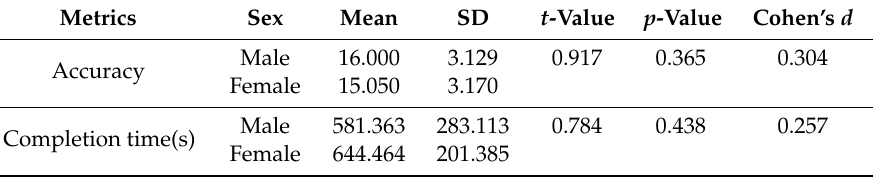
Table 1. Accuracy and completion time between males and females.